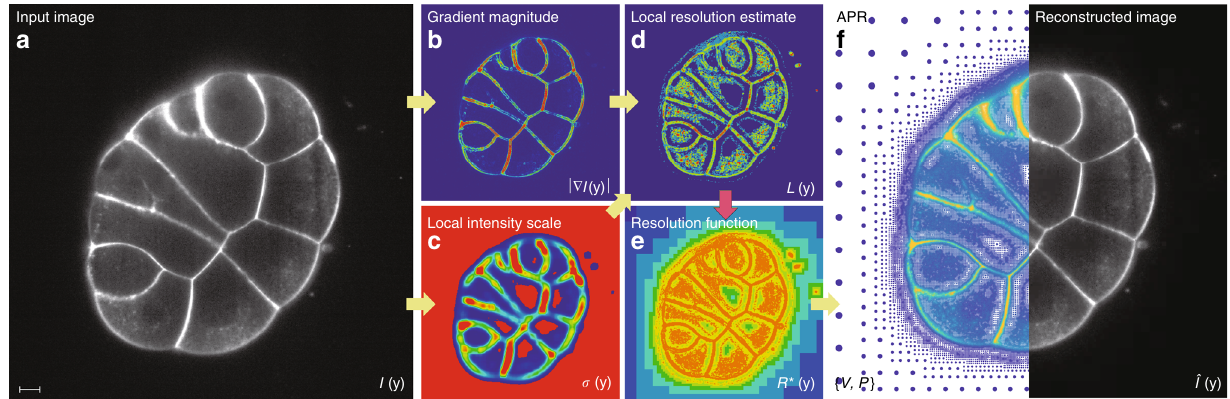
Fig. 6 Procedure for forming the APR in 3D. a 2D slice of exemplar dataset 10 (courtesy of Lemaire lab, CRBM (CNRS) and Hufnagel lab, EMBL 34,35 ). b First, the intensity gradient magnitude | ∇ I ( y )| and c the Local Intensity Scale σ ( y ) are calculated from the input image. These two are then combined to compute the Local Resolution Estimate L ( y ) ( d ). e The Pulling Scheme (red arrow) uses L ( y ) to compute the optimal Implied Resolution Function R * ( y ). f This is then used to de fi ne the Optimal Valid Particle Cell set V and the particle locations P , which together form the APR. The APR is visualized both as particles with color encoding intensity and size encoding local resolution, and as a piecewise constant reconstruction ^ I ð y Þ of the image. Scale bar